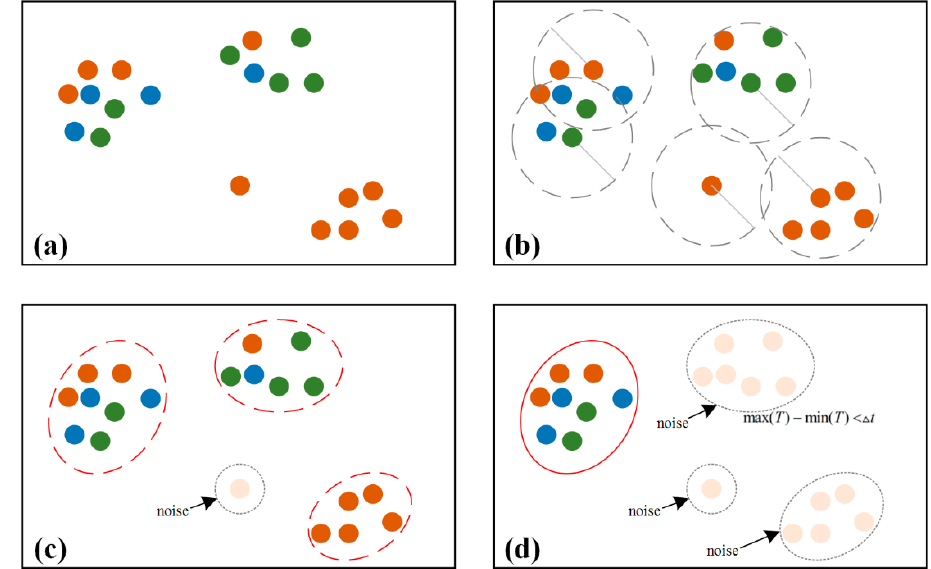
Figure 2. Illustration of TU-DJ-Cluster: ( a ) the dataset; ( b ) the process of calculating the neighbourhood; ( c ) initial cluster results; ( d ) final cluster results and noise points.